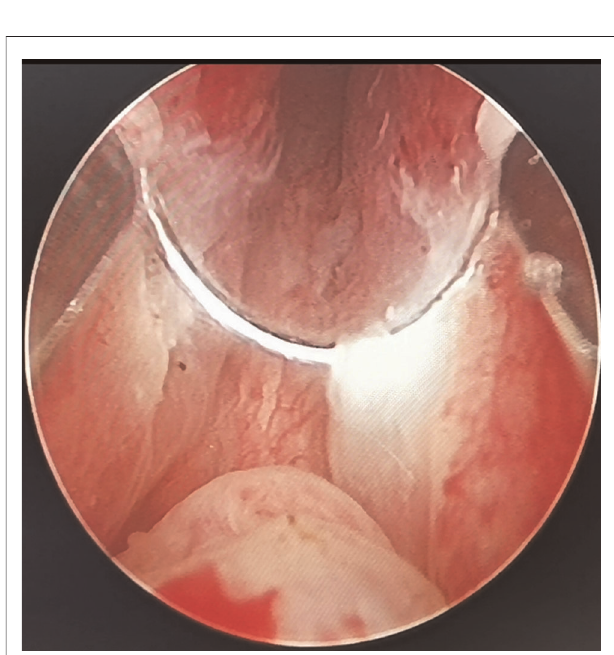
FIGURE 1 | Annular bulge of the urethral mucosa caused by the external urethral sphincter, the prostatic apex protruding into the urethral